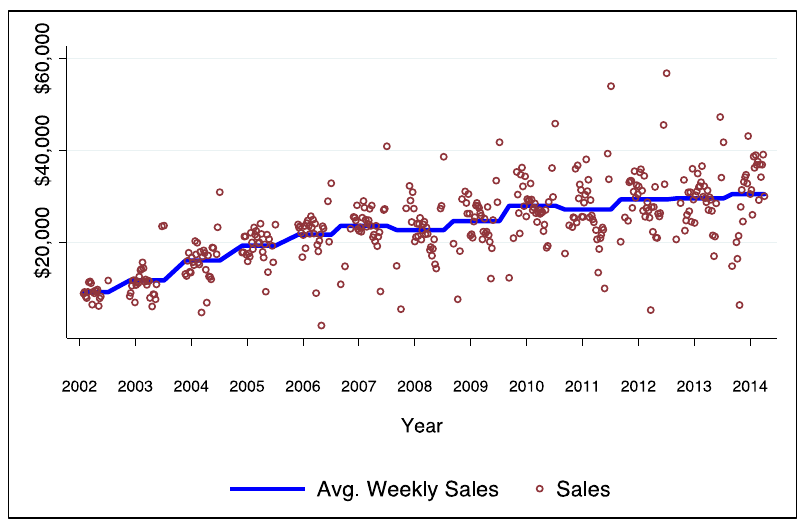
Figure 2. Aggregate Weekly Sales Data at the Williamsburg Farmers Market, 2002–2014 (Adjusted for Inflation in 2010